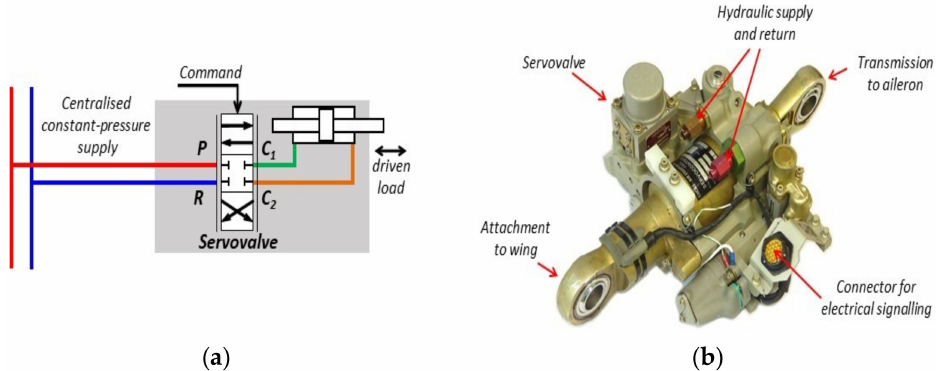
Figure 3. Hydraulically supplied, electrohydraulic servoactuator: ( a ) Control of power through throttling from a constant pressure source; ( b ) Airbus A320 aileron actuator with its servovalve.